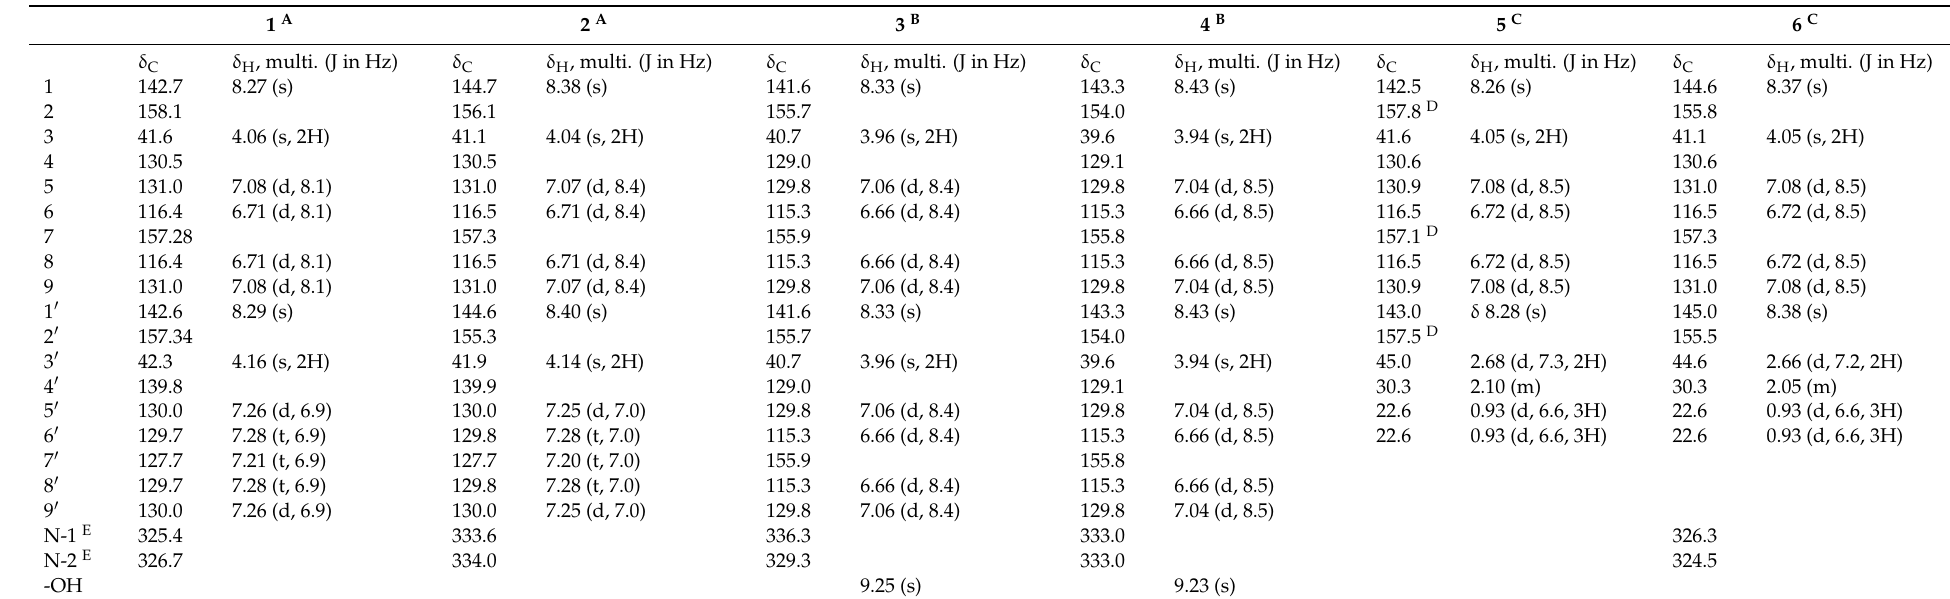
Table 1. 1 H and 13 C NMR data of compounds 1 – 6